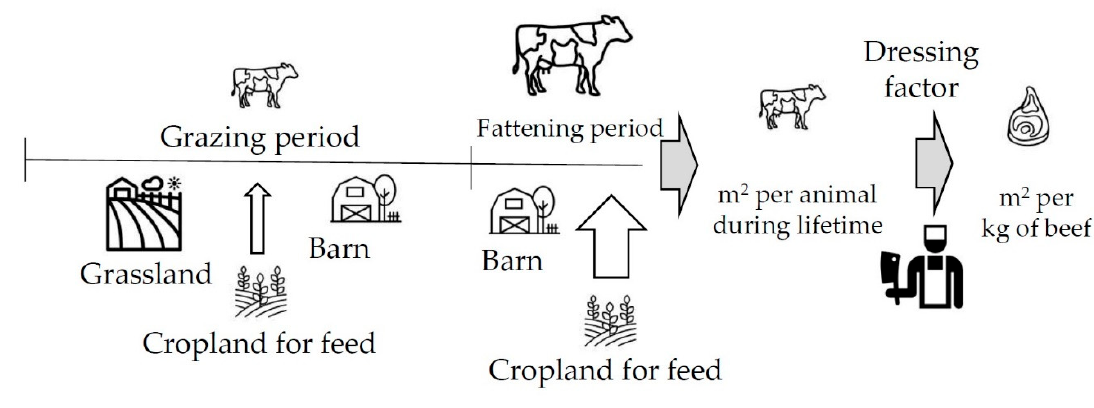
Figure 2. Beef production system. Source of icons: the Noun Project [15].